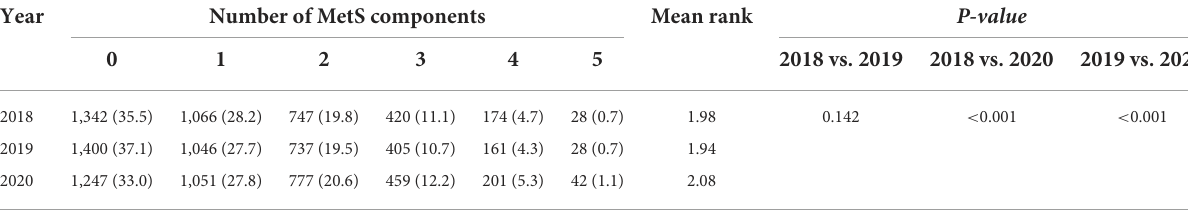
TABLE 2 Numbers of abnormal MetS components from 2018 to 2020.